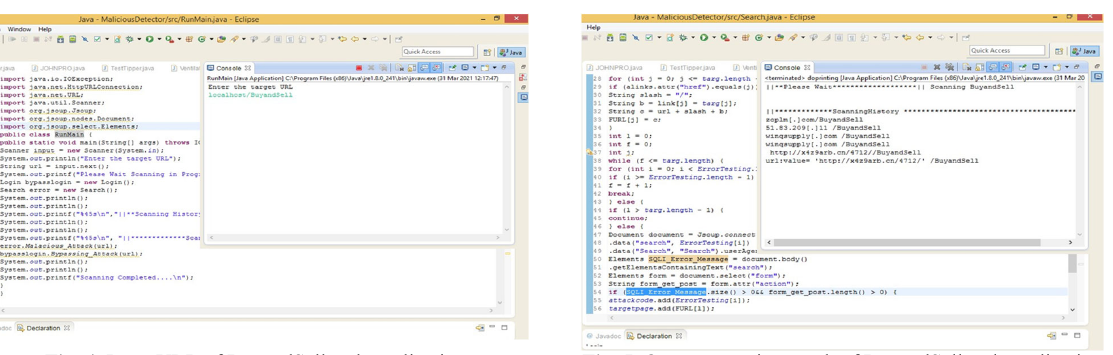
Fig. 4. Input URL of BuyandSell web application Fig. 5. Output scanning result of BuyandSell web application